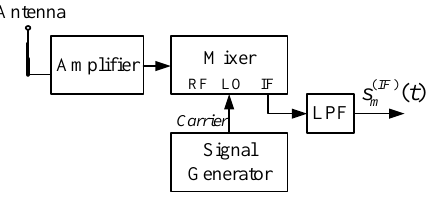
Figure 10. Block diagram of one RF